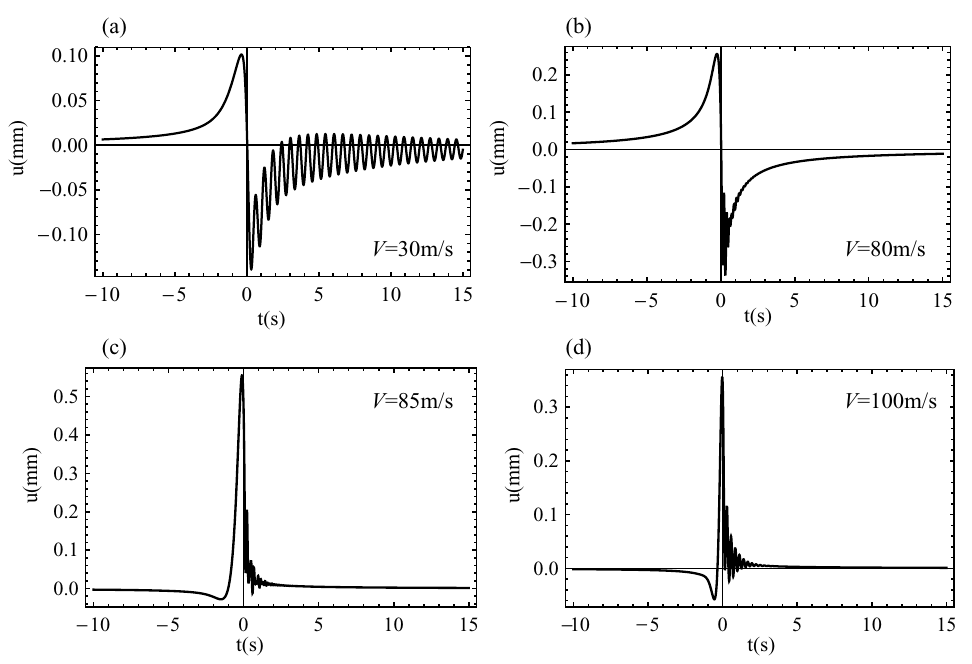
Fig. 8. The horizontal displacement for the velocity: (a) V = 30 m/s, (b) V = 80 m/s, (c) V = 85 m/s, (d) V = 100 m/s. can be interpreted as the moment at which the changes of the system behaviour related to the ground vibration boom phenomenon start